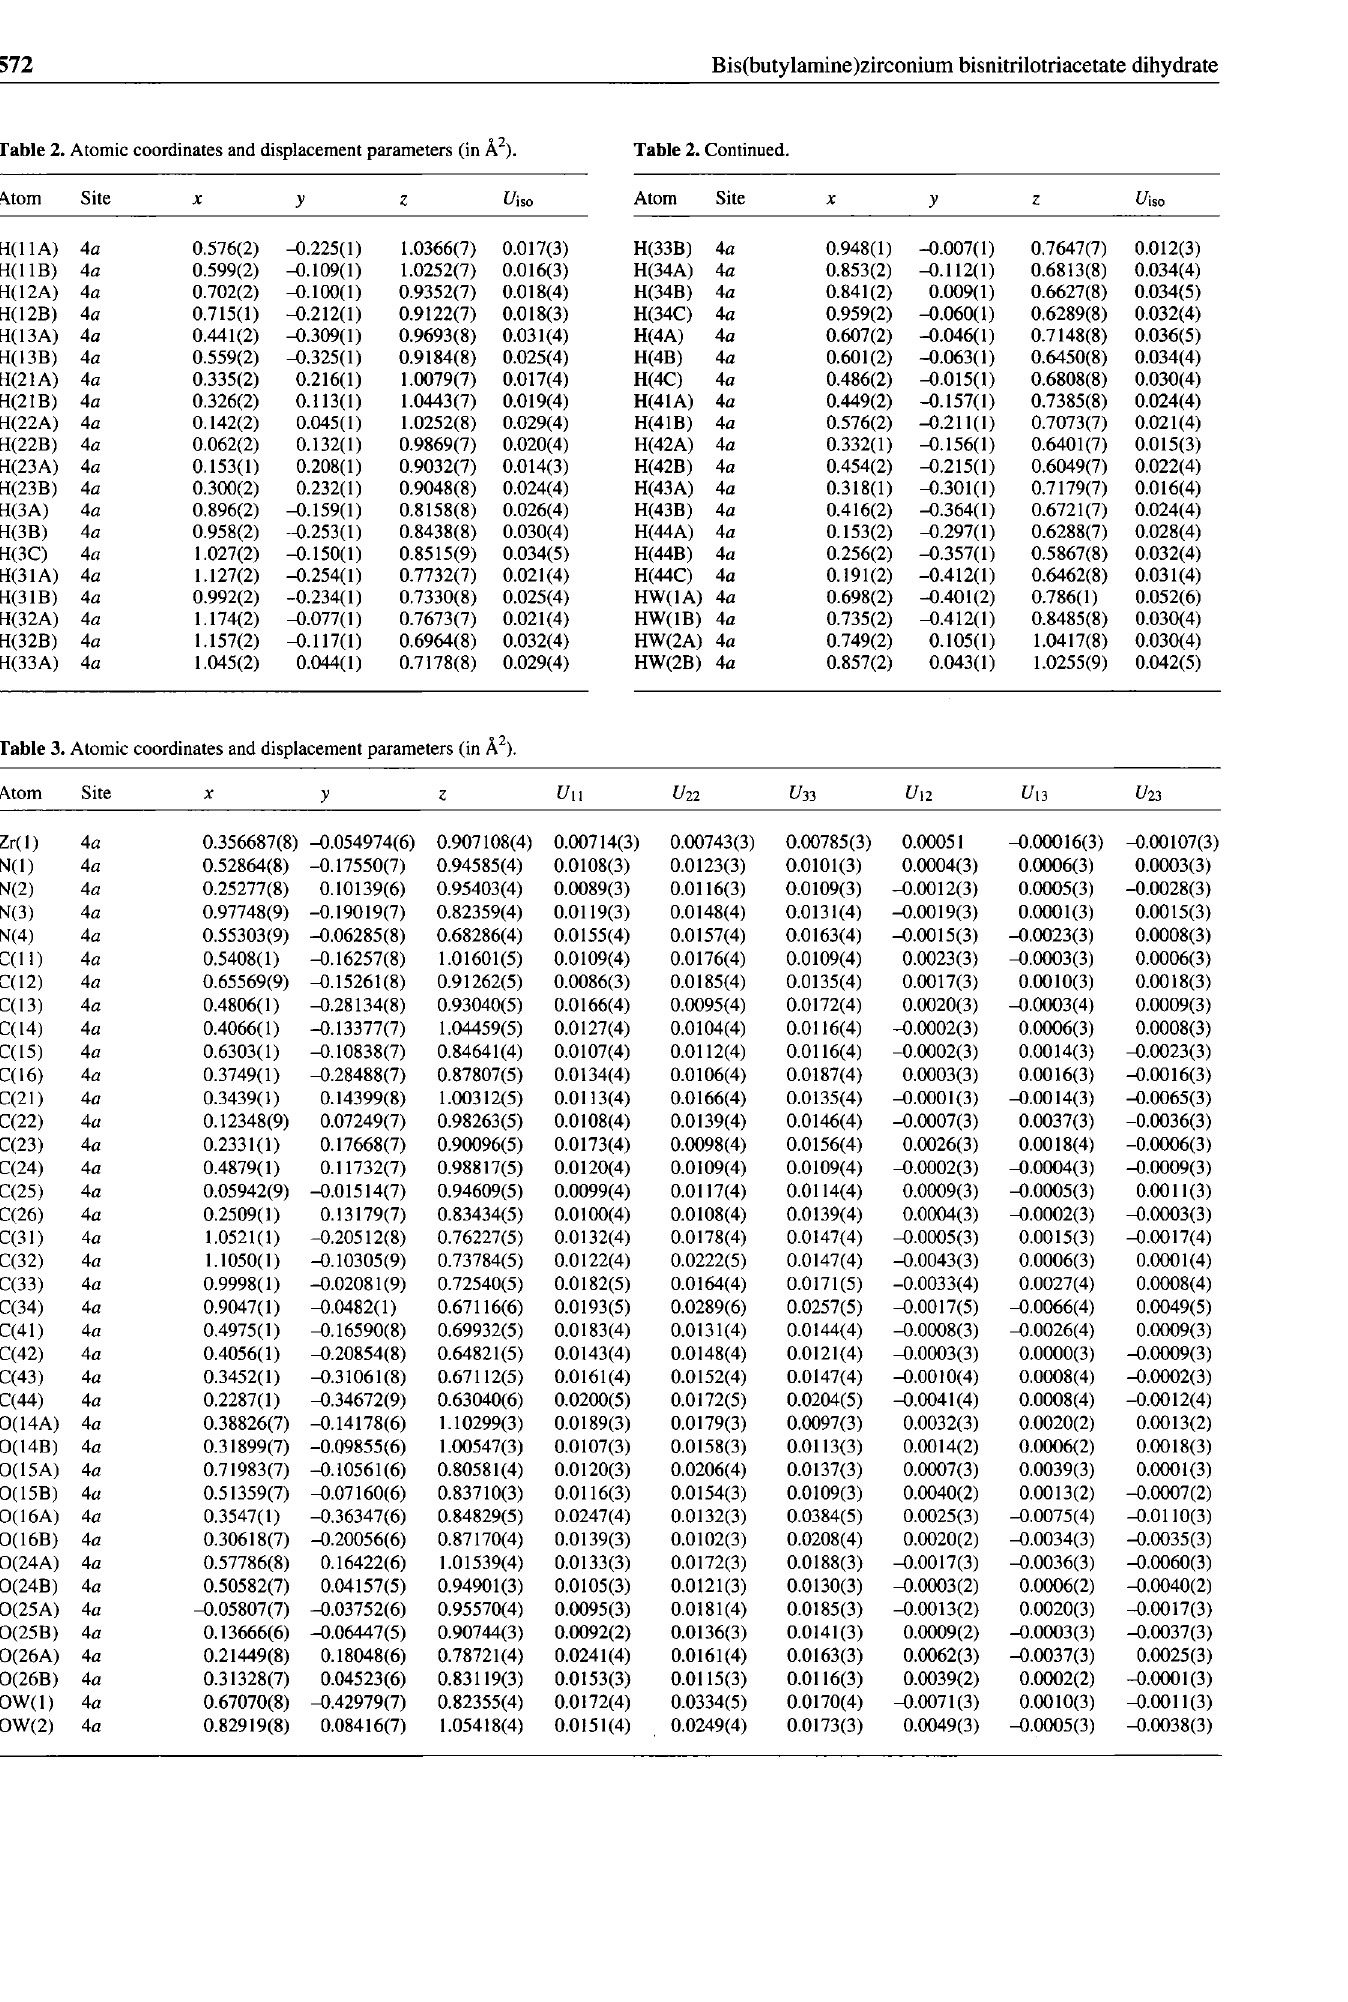
Table 2. Atomic coordinates and displacement parameters (in Ä 2 ).